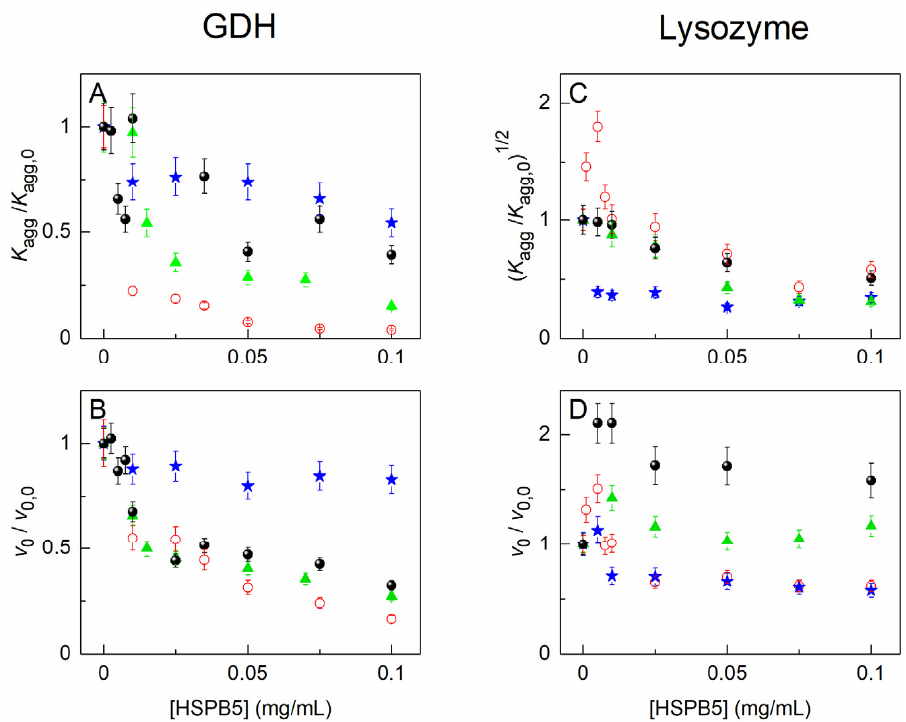
Figure 2. The effect of HSPB5 on the kinetics of thermal aggregation of GDH and DTT-induced aggregation of Lyz. ( A , B ) The dependences of K agg / K agg,0 and v 0 / v 0,0 ratios, respectively, on HSPB5 concentration for aggregation of 0.2 mg/mL GDH at 50 °C (0.1 M Na-phosphate buffer, 10 mM NaCl, pH 7.6). ( C , D ) The dependences of ( K agg / K agg,0 ) 1/2 and v 0 / v 0,0 ratios, respectively, on HSPB5 concentration for aggregation of 0.15 mg/mL Lyz at 37 °C (0.1 M Na-phosphate buffer, 10 mM NaCl, 20 mM DTT, pH 7.6). Open red circles correspond to the values obtained in the buffer; blue stars—in the presence of 25 mg/mL PEG; green triangles—in the presence of 1 M Bet; and filled black circles—in the presence of both 25 mg/mL PEG and 1 M Bet.